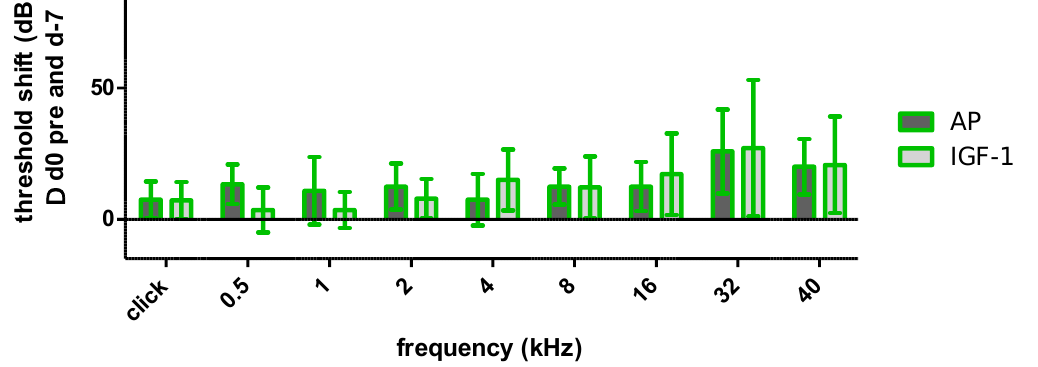
Figure 3. Mean and standard deviation (SD) threshold shift of the implanted ears of both treatment groups one week after surgery before noise trauma. AP displayed in dark grey and IGF-1 in light grey. There was no significant difference between groups.